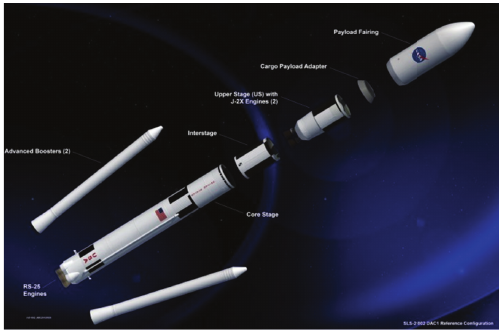
Figure 7: This picture (adapted and modified from [35]) describes one of the models of the SLS. The SLS will be the most powerful space launch vehicle ever flown. Additional boost from a pair of the largest solid rocket motors (SRBs) ever to be built will be required to lift the payload into orbit. The assembly/stacking of the different boosters, stages/phases, and the MPCV will occur at the